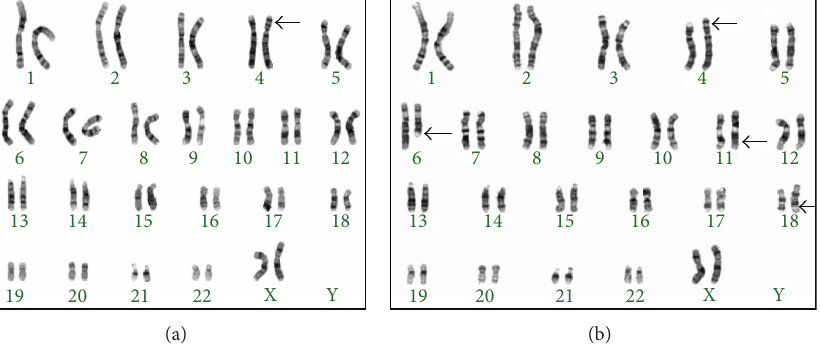
Figure 2: Karyotyping result: (a) proband and (b) mother and grandmother.